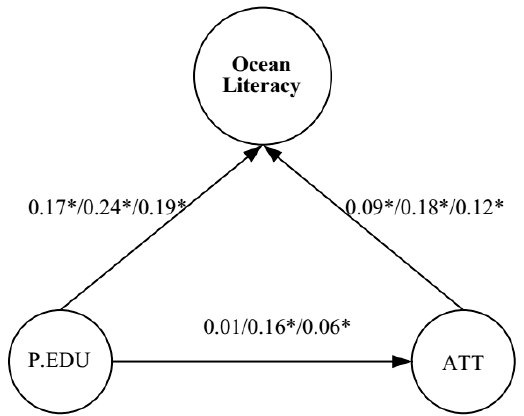
Figure 2. Standardized estimates of relations and effect sizes in structural model. Note: Female group N = 396, male group N = 549, and total sample N = 945. PEL = parental educational level; ATO = attitude toward the ocean; the first value, second value, and third value shown are for the male group, the female group, and the total sample, respectively. * indicates statistically significant ( p < 0.05).